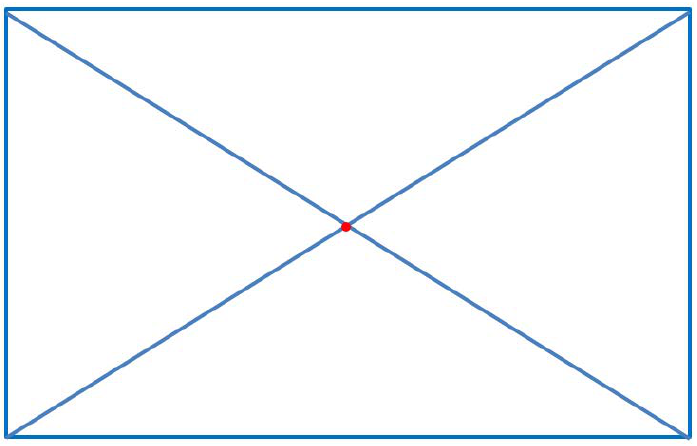
Figure 11. Finding and marking the center. Source: the author.